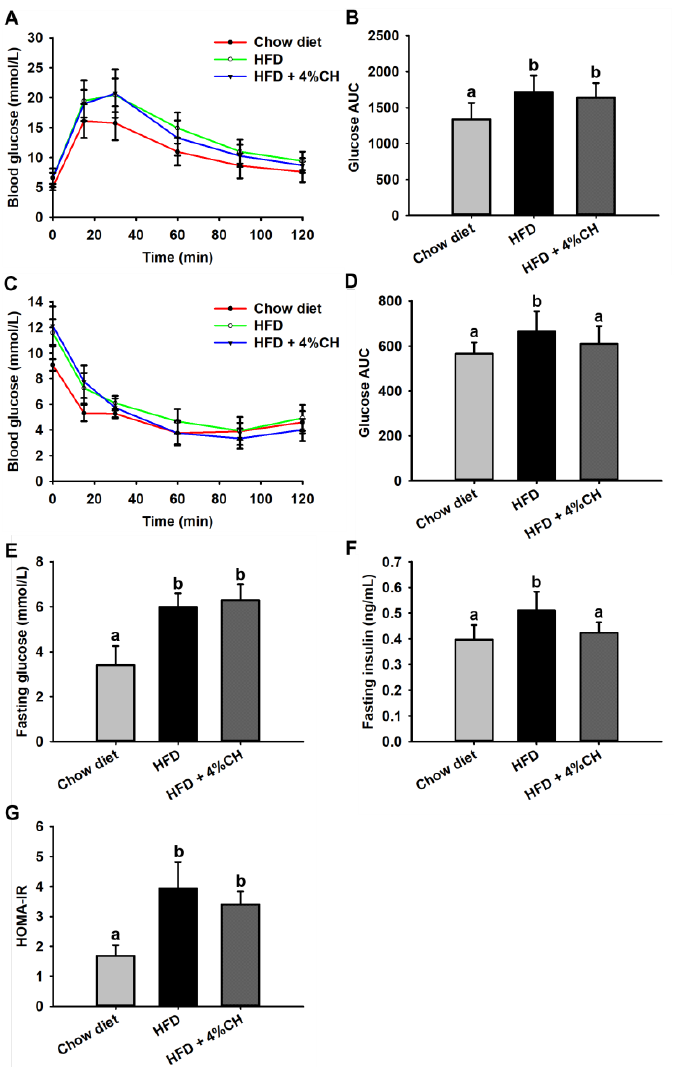
Figure 3. The effects of CH supplementation on the blood glucose tolerance and insulin tolerance of mice fed with HFD. The curve of blood glucose level at different time intervals in OGTT assay ( A ) and the AUC value of blood glucose curve in OGTT assay ( B ), the curve of blood glucose level at different time intervals in IPITT assay ( C ) and the AUC value of blood glucose curve in IPITT assay ( D ), fasting glucose level ( E ), fasting insulin level ( F ) and HOMA-IR ( G ), all values were exhibited as means ± SD ( n = 12). Different letters indicated statistically significant difference at p < 0.05.